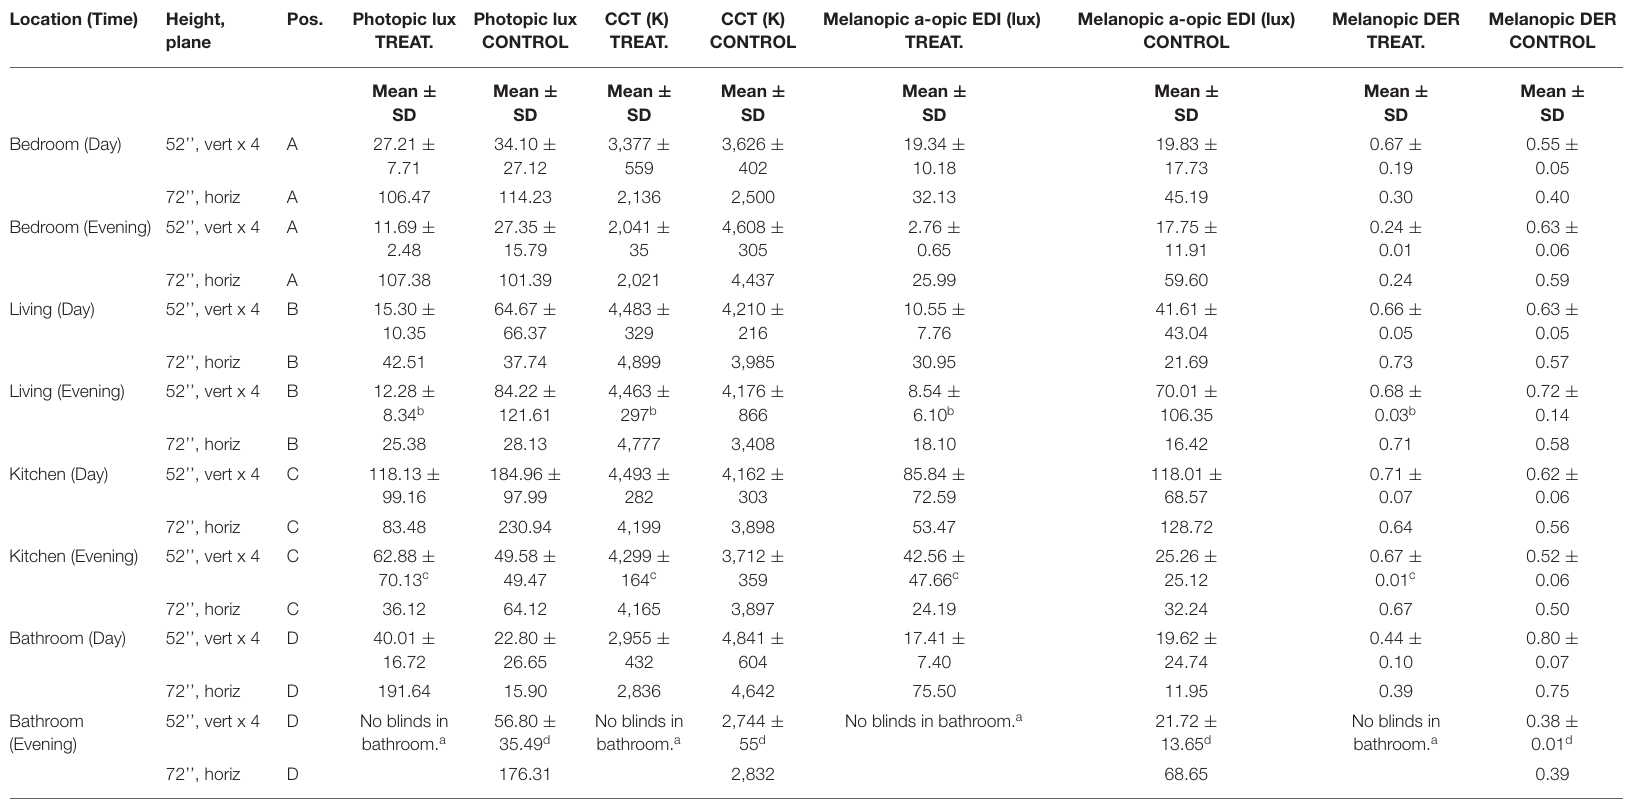
TABLE 3 | Case 2 Treatment and Control condition lighting